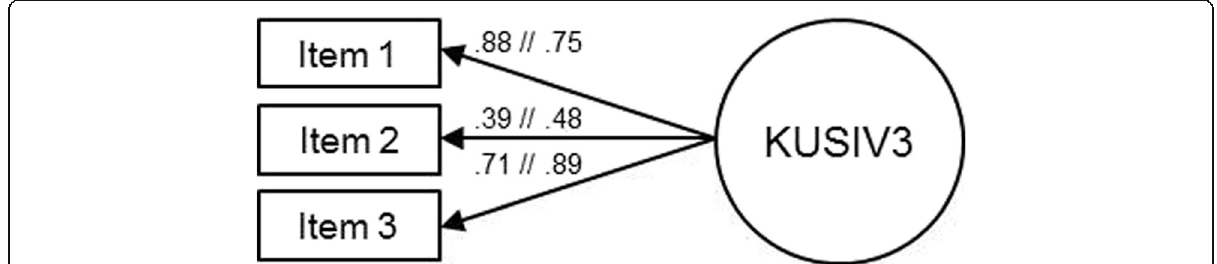
Fig. 1 Unidimensional measurement model of KUSIV3 with standardized coefficients. The negatively keyed item is reverse-scored. The coefficients of the German sample are presented after the double slash. Item error terms are omitted for clarity. N UK = 468; N DE = 474